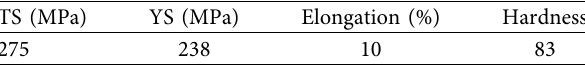
Table 2: Properties of Al 6082.